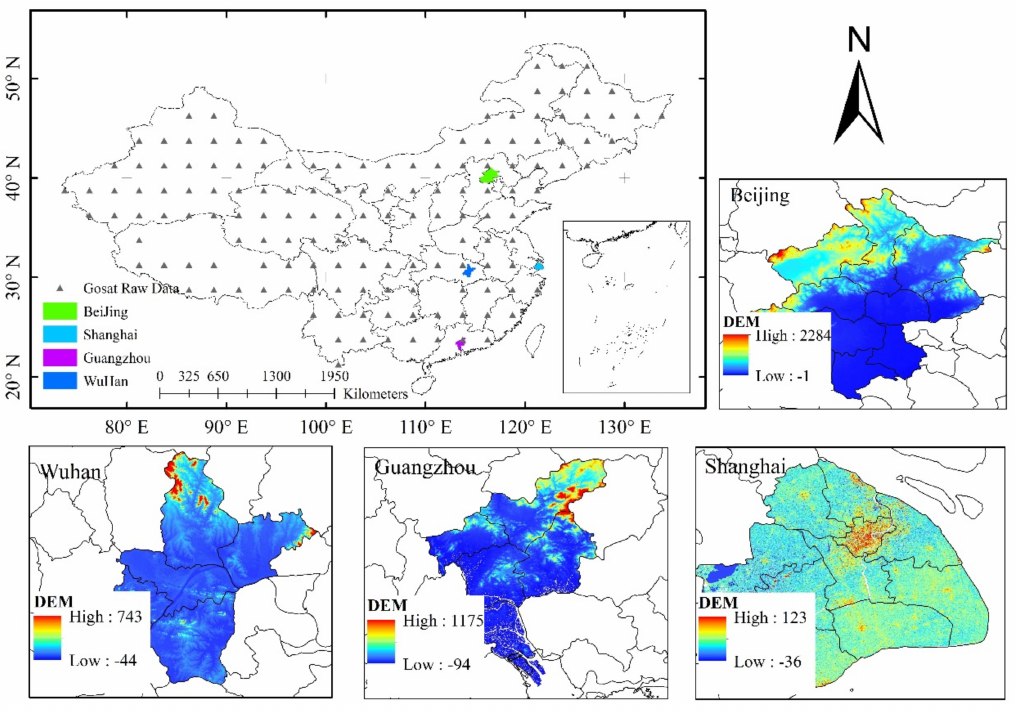
Figure 1. Map of the study